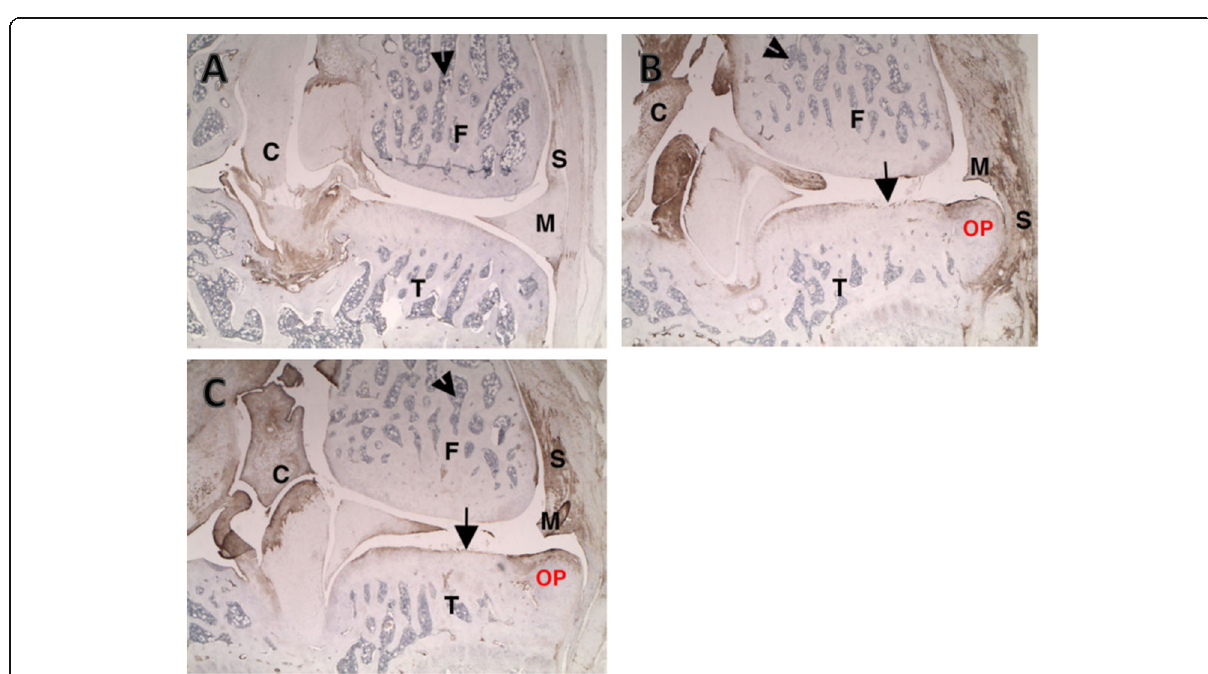
Fig. 6 TGF β staining on the medial tibial surface. a Uninjected left knee. Arrowhead identifies bone marrow. Note normal immunopositivity in connective tissue of synovium (S), collateral ligament joint capsule, and cruciates (small C). b PBS injected right knee. Note increased connective tissue staining in healing medial synovium (S) damaged meniscus (M), cruciates (small C), and osteophyte (OP). The damaged tibial cartilage has increased staining of the tangential layer in areas where it is intact. c IA-BioHA (0.5 mg/rat) injected at Days 7, 14, and 21 in the right knee. Note increased connective tissue staining in healing medial synovium (S) damaged meniscus (M), cruciates (small C), and osteophyte (OP). The damaged tibial cartilage has increased staining of the tangential layer in areas where it is intact. F- femur; M – meniscus; T – tibia. Images were acquired at 25x